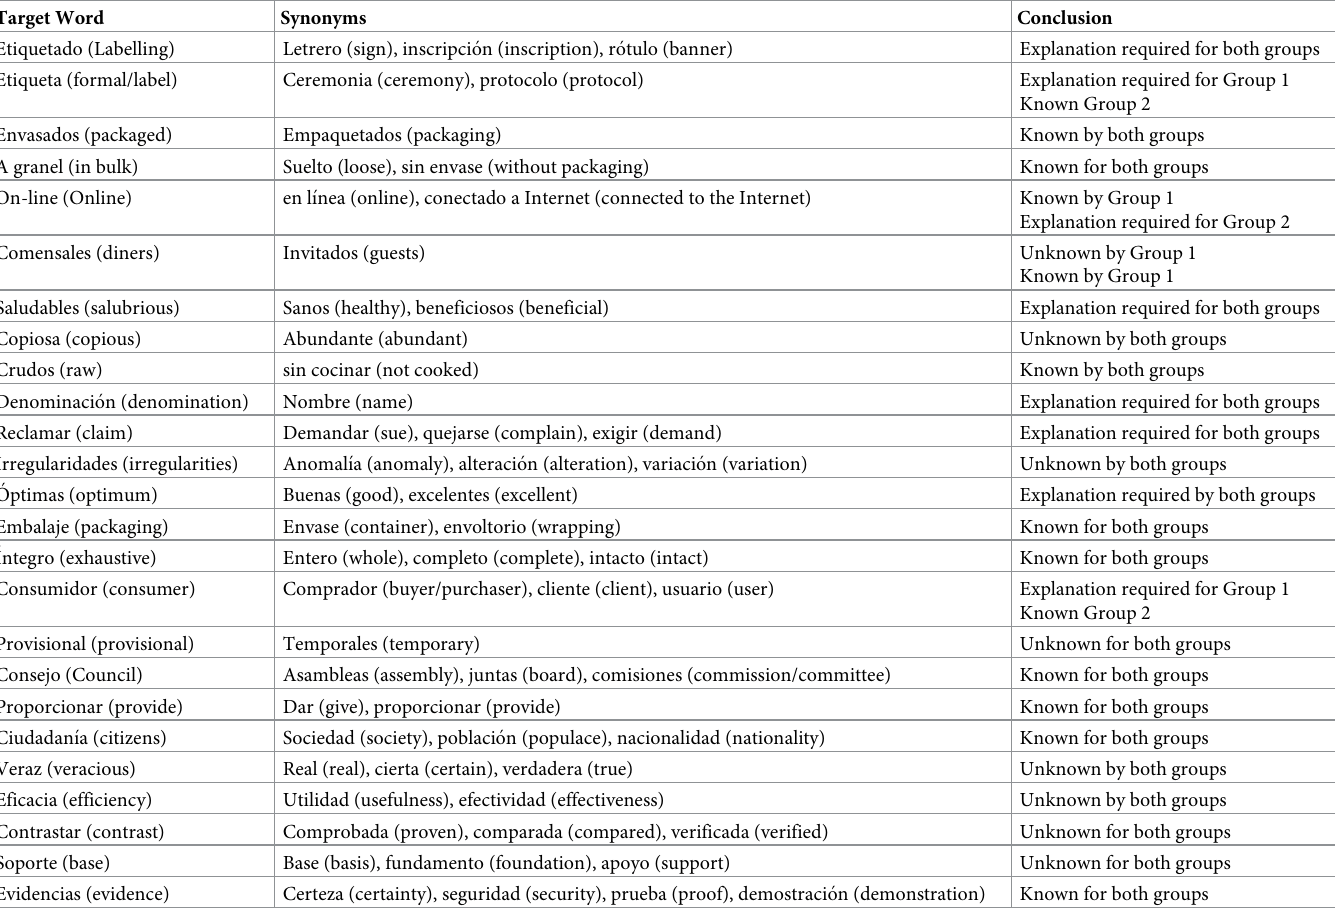
Table 2. An extract of the target/synonym dataset for human evaluation with Group 1 (people with mild intellectual disabilities) and Group 2 (older